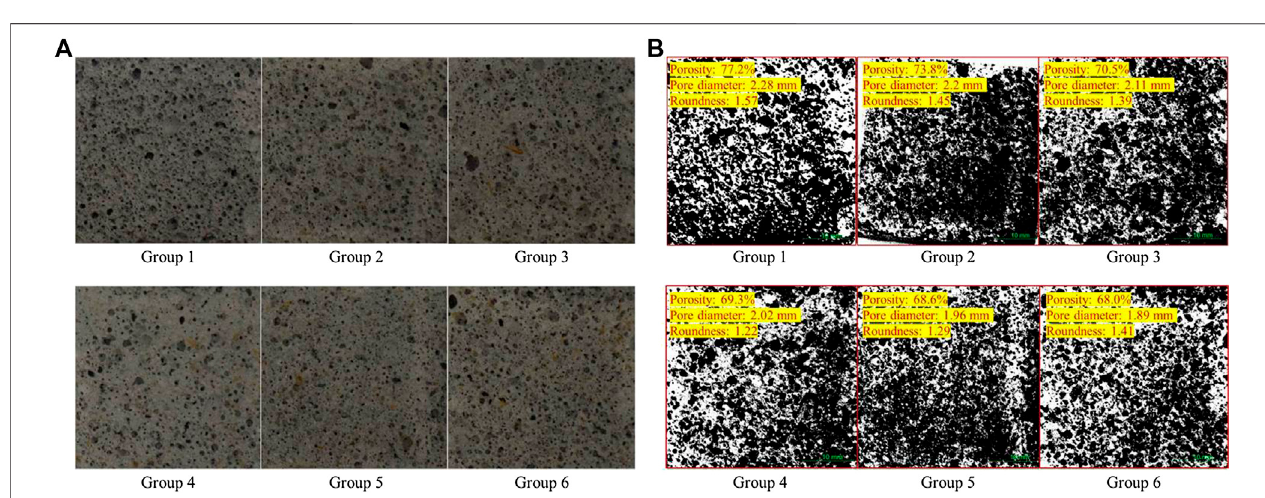
FIGURE 10 | Pore structure (A) High-de fi nition photo of specimen sections (B) Pore structure parameters.